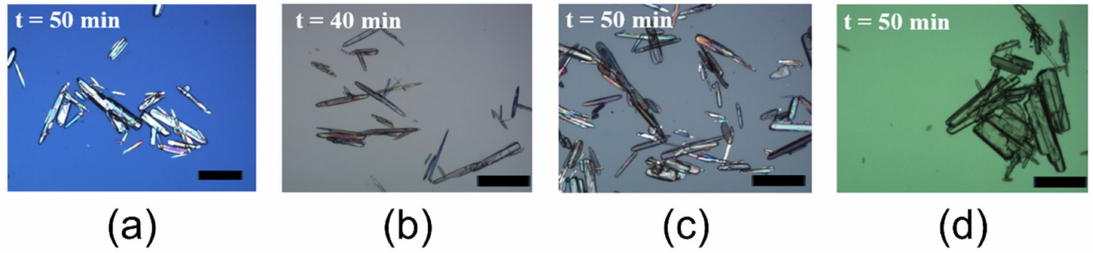
Figure 7. Representative OM images of 2:1 HBz–NaBz co-crystals generated at S 0 = 1.66: ( a ) without templating molecules, ( b ) with dissolved NaBz templating molecules, ( c ) with dissolved 2:1 HBz–NaBz co-crystal templating molecules, and ( d ) with dissolved 1:1 HBz–NaBz co-crystal templating